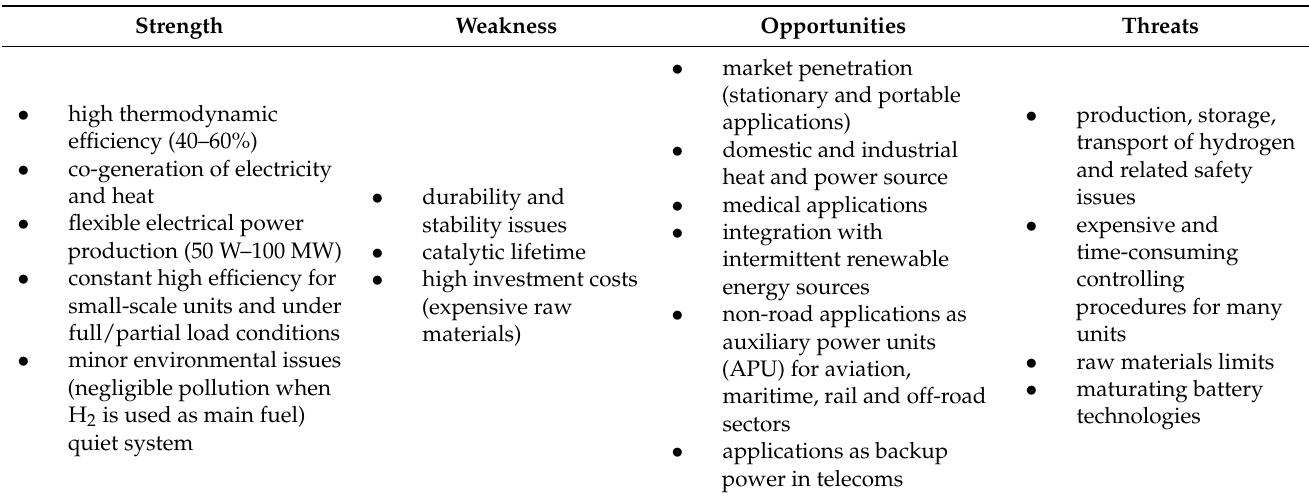
Table 8. SWOT analysis of fuel